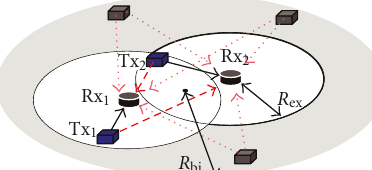
Figure 9: Background interferers scenario: additional transmitters are added with a minimum distance R ex to the intended receivers Rx 1 and Rx 2 . Intended transmitters and receivers are drawn from a disk of radius R = 100 m (not shown), while interfering transmitters are drawn from a larger concentric disk of radius R bi = 1000m. Receivers and transmitters are shown as cylinders and rectangular boxes. Solid and dashed arrows account for intended and interfering communication links,